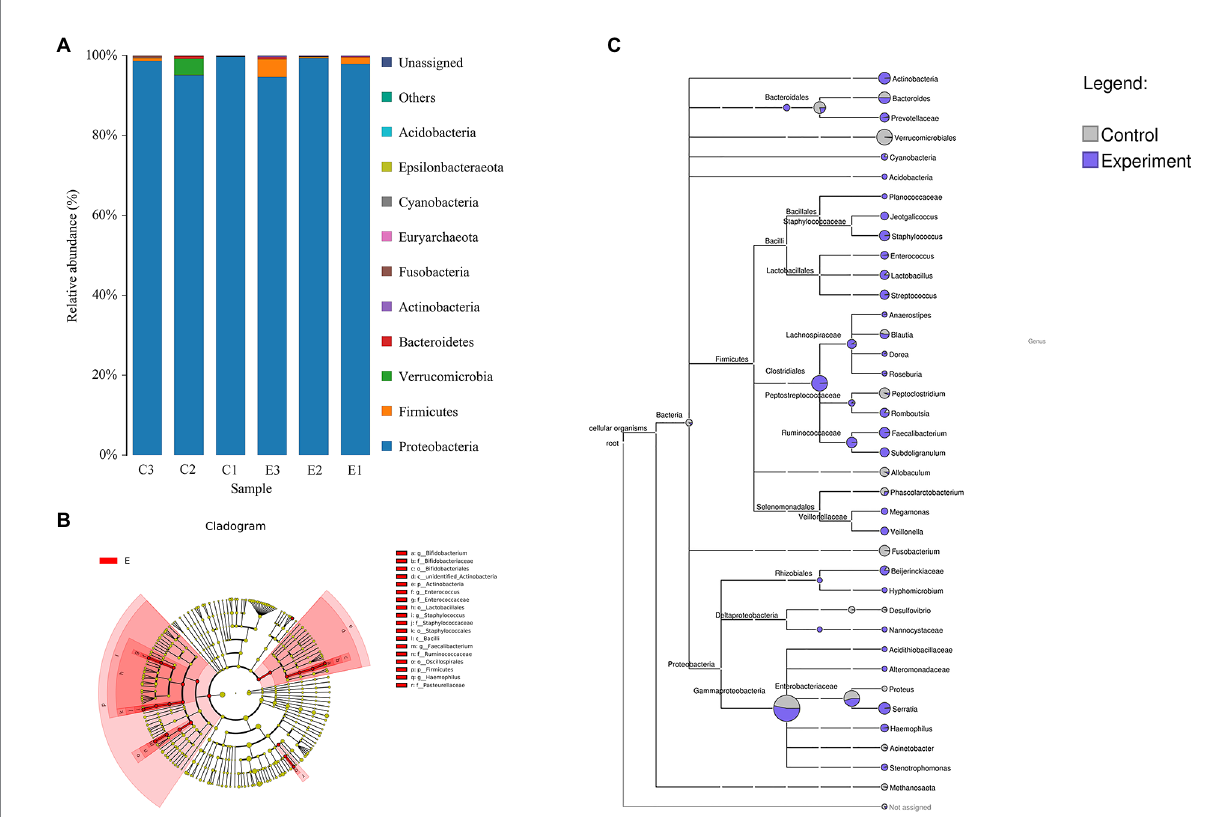
FIGURE 5 Changes in the intestinal microbial composition of Chinese sea bass after Aeromonas hydrophila infection. (A) Species annotation of intestinal microbes at the phylum level. (B) Taxonomic system relationship tree analysis of intestinal microbes. (C) Linear discriminant analysis (LDA) revealed significant differences in the intestinal microbiota. (LDA > 2, p < 0.05).